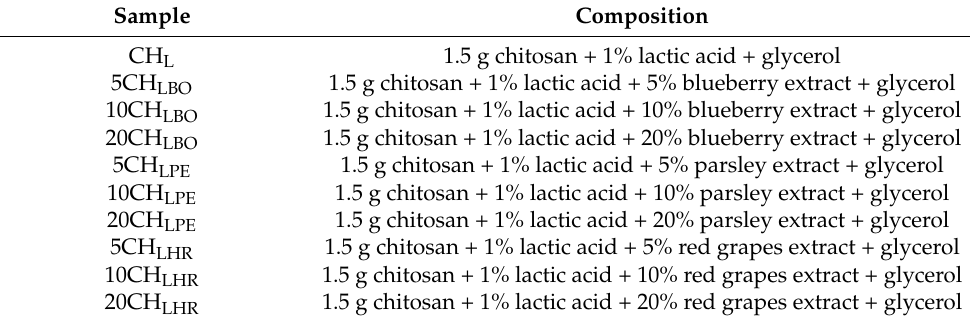
Table 1. Composition of prepared